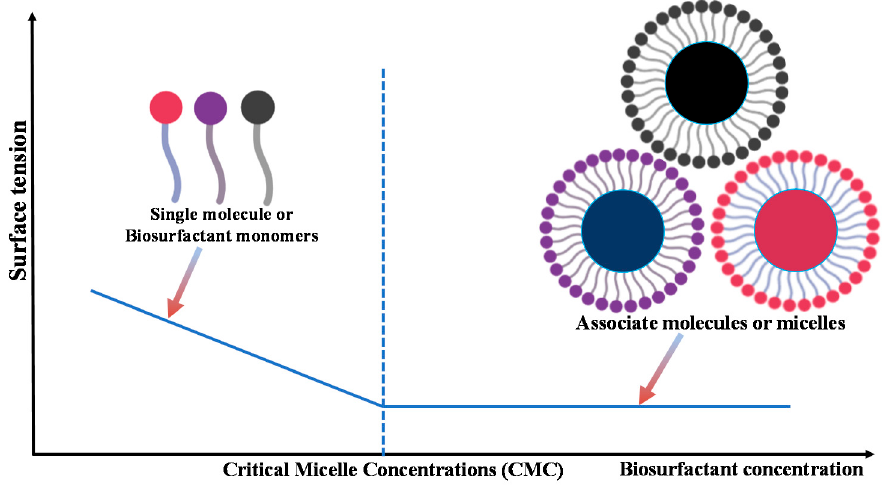
Figure 1. Critical micelle concentration (CMC) and micelle formation of biosurfactant monomers.